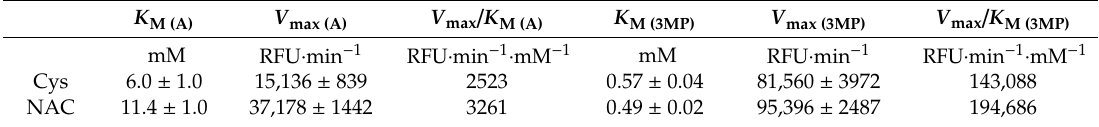
Table 1. Kinetic parameters of human MST.